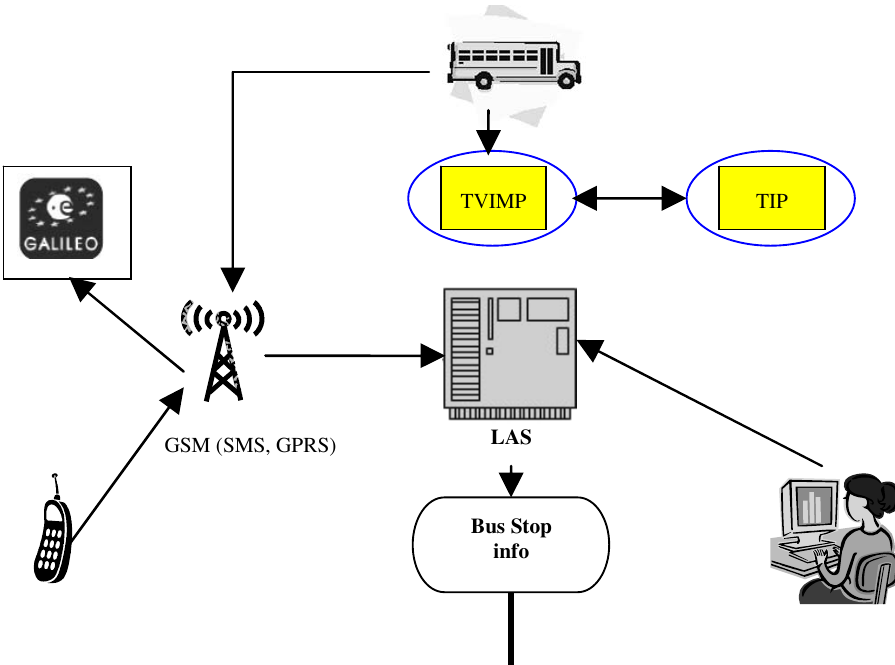
Fig 3. Remote identification system for passenger